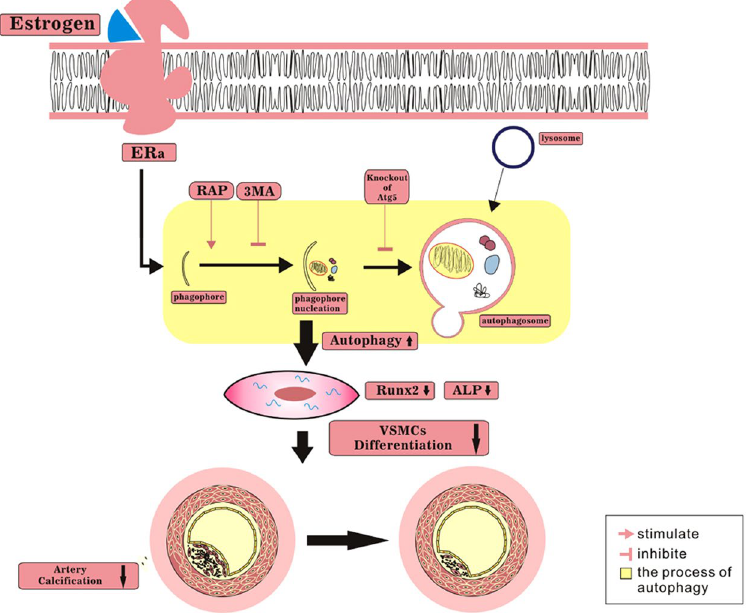
Figure 7. A proposed model of the effect of oestrogen on arterial calcification. Oestrogen enhanced the level of autophagy, which inhibited the differentiation of VSMCs and arterial calcification through ER α . Rapamycin further enhanced the inhibitory effect of oestrogen, whereas 3MA or knockdown of Atg5 impaired the inhibitory effect of